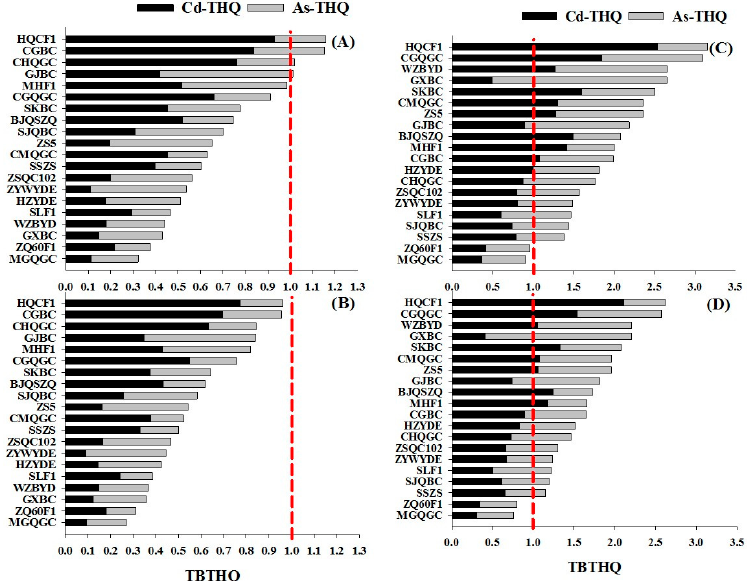
Figure 6. The total bioaccessible target hazard quotients (TBTHQs) of Cd and As via consumption of 20 pakchoi genotypes from low ‐ level co ‐ contaminated soils for children ( A ) and adults ( B ), as well as for high ‐ level co ‐ contaminated soil for children ( C ) and adults ( D ). The dotted red line represents for the tolerable limits of target hazard quotient (<1) set by USEPA [39]. Table 3. The bioaccessible value of estimated daily intake (BEDI) ( μ g kg − 1 bw ∙ day − 1 ) for Cd and As from consumption of pakchoi cultured on low ‐ level co ‐ contaminated soil (L ‐ C soil), and high ‐ level co ‐ contaminated soil (H ‐ C soil).